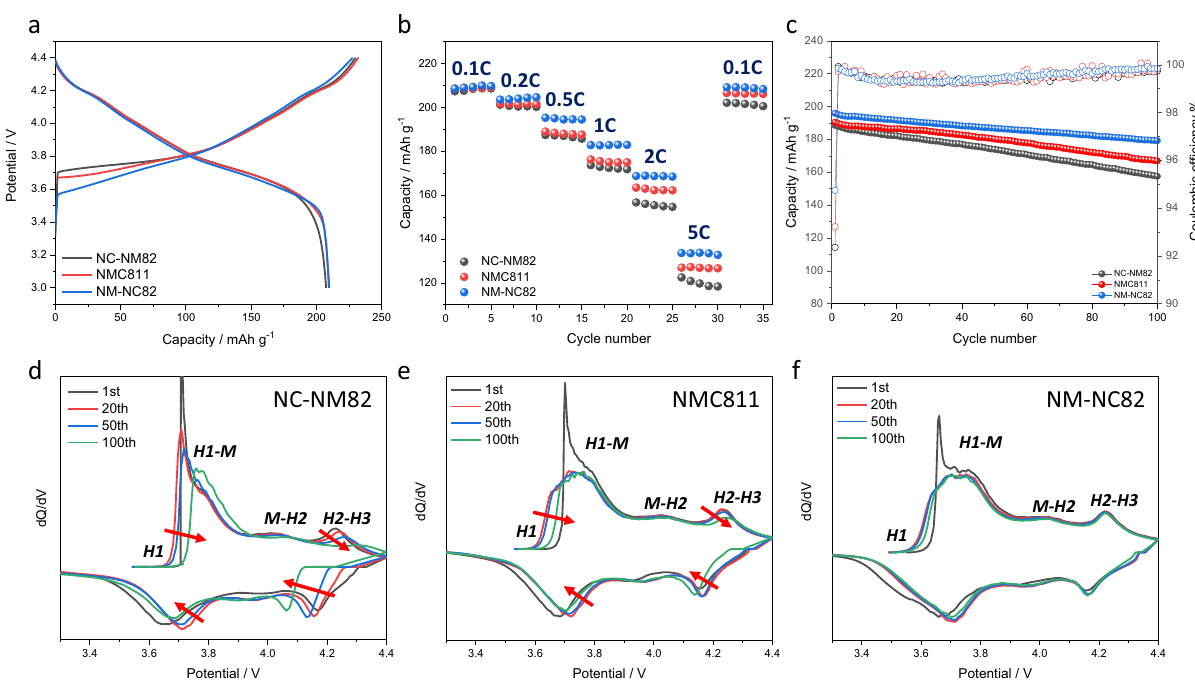
Fig. 4 Electrochemical measurements of two gradient cathodes. a Initial charge/discharge pro fi le of the NC-NM82, NMC811, and NM-NC82 at 0.1C and a cut-off potential of 4.4 V. b Rate capability of the NC-NM82, NMC811, and NM-NC82. c Cycling performance of the NC-NM82, NMC811, and NM-NC82 at a current rate of C/2 within a voltage range of 2.8 – 4.4 V after three activation cycles. d d Q /d V curve at different cycles of NC-NM82. e d Q /d V curve at different cycles of NMC811. f d Q /d V curve at different cycles of